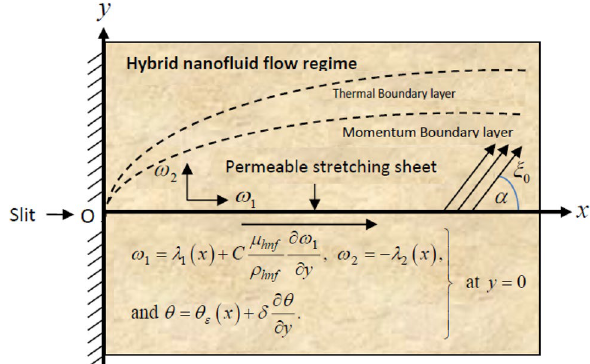
Figure 1. Physical representation of the